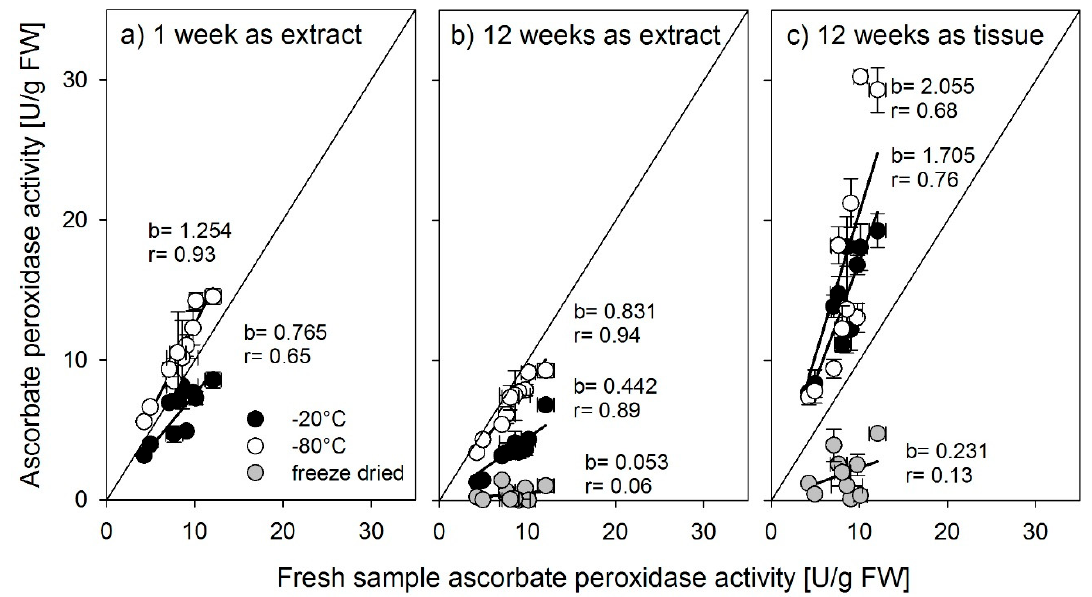
Figure 6. Ascorbate peroxidase activity determined from fresh samples compared with activity determined after storage at − 20 °C, (black symbols), − 80 °C (open symbols), or freeze-dried extracts of tissue (gray symbols) for ( a ) 1 week storage time or ( b,c ) 12 weeks storage time. b = slope of the regression line, r = the correlation coefficient r 2 . Error bars = standard error of mean (n = 3).